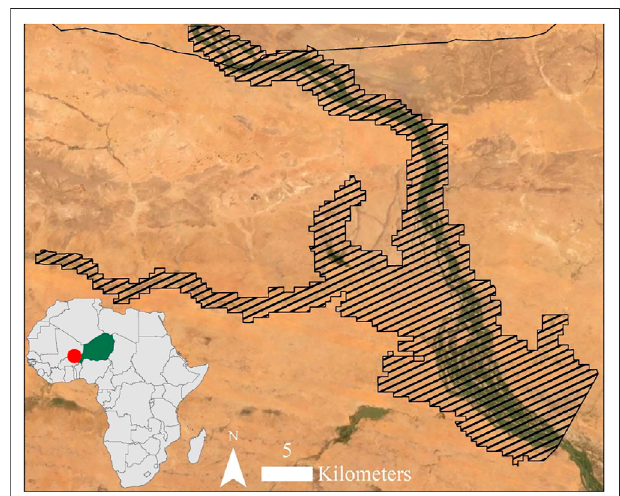
FIGURE 1 | Map showing the study area in Southern Niger indicated by the hatch